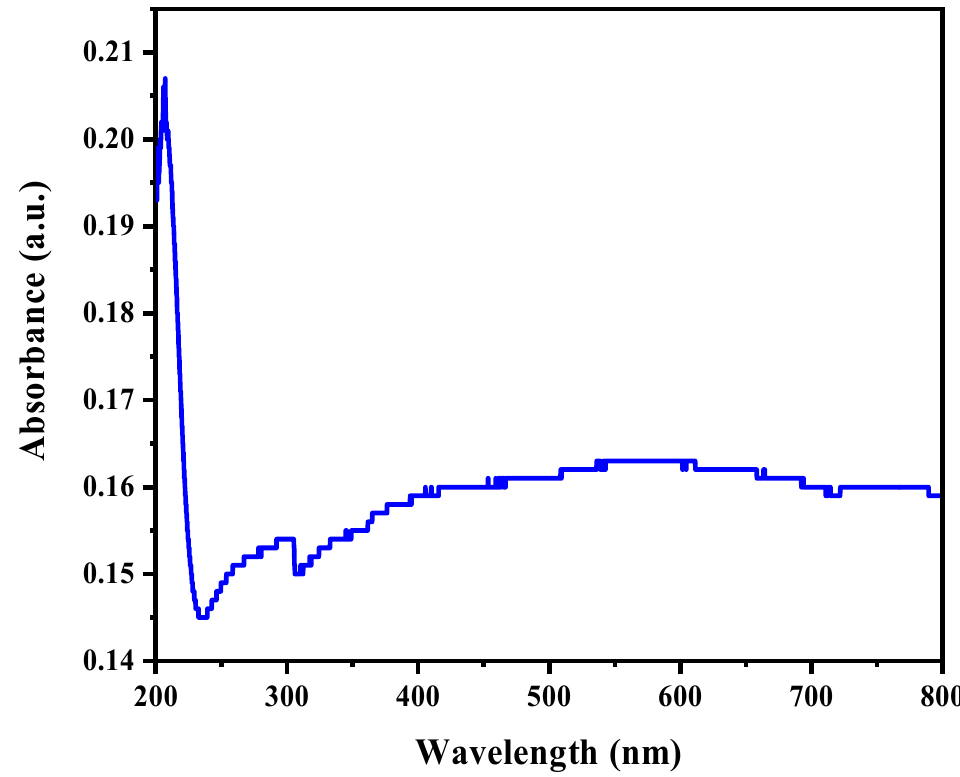
Figure 5. UV-vis absorption spectrum of rGO-CuO nanocomposites.